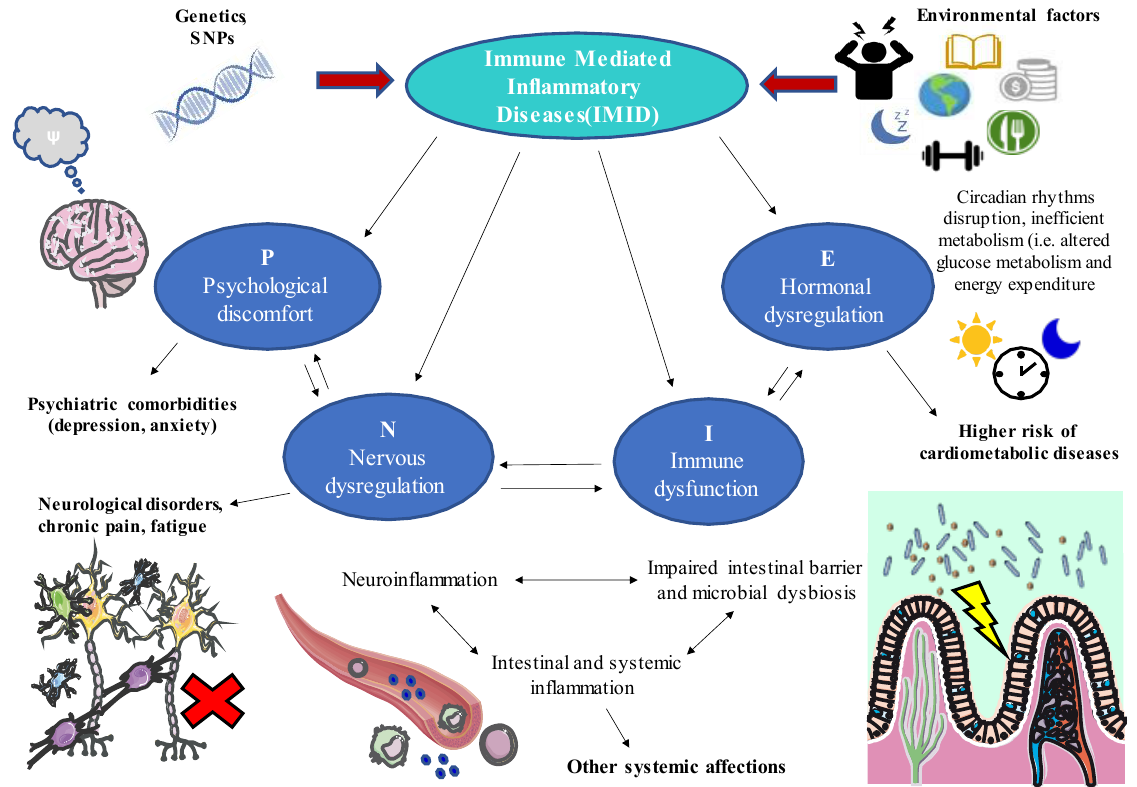
Figure 1. A global perspective of the role of psychoneuroimmunoendocrinology (PNIE) in immune- mediated inflammatory diseases (IMIDs). As shown, different psychological (P), neurological (N), immune (I), and endocrine (E) factors will interact significantly during IMID, which are in turn influ- enced by a series of environmental and genetic factors. Thus, these patients present various ailments and manifestations that go beyond the pathophysiology of the disease itself. For example, it is common to observe a systemic inflammatory response that also affects other organs, such as the brain (neuroin- flammation), intestine (intestinal permeability, microbial dysbiosis), or endocrine system